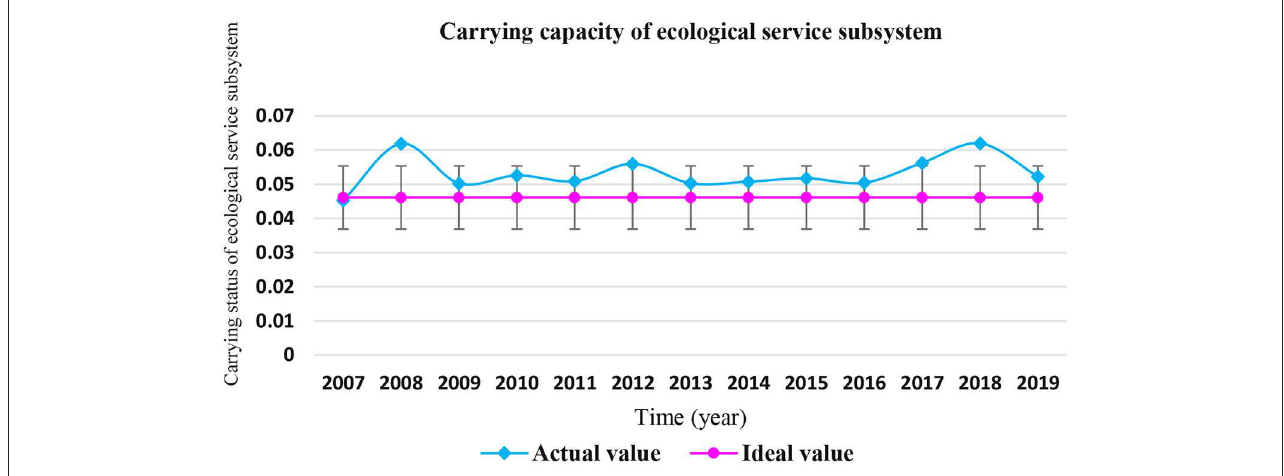
FIGURE6 Carrying status of coastal ecological service subsystem in Shandong Province from 2007 to 2019.